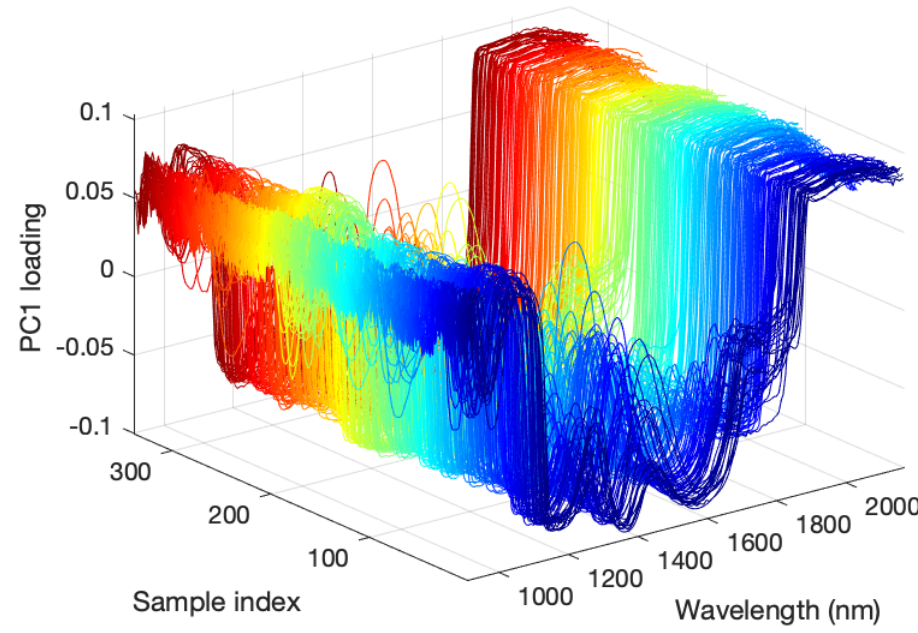
Figure 5. PC1 loadings of all samples obtained by principal component analysis from the pixels of the hyperspectral data measurement plane.